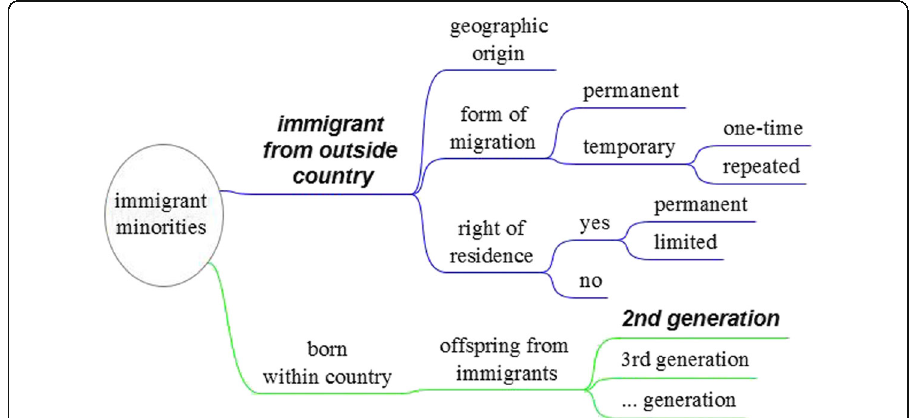
Fig. 1 Immigrant minorities. Notes : Subgroups highlighted about which Eurostat provides statistical